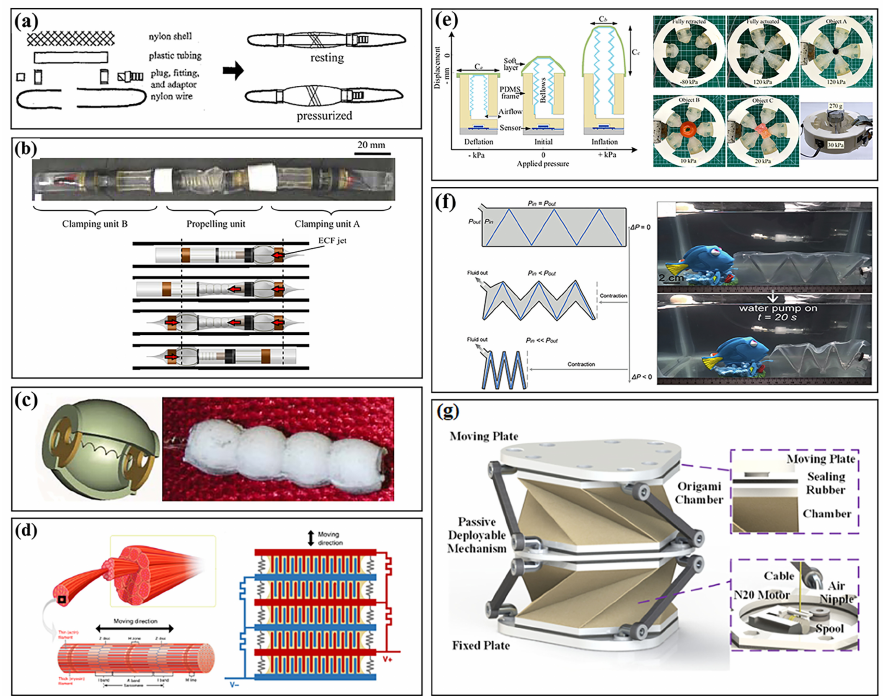
Figure 10. ( a ) The composition structure of McKibben artificial muscle and the forms in two states [88]. ( b ) The in-pipe mobile robot and locomotion of the in-pipe mobile robot [89]. ( c ) The structure of the module and the artificial earthworm prototype [90]. ( d ) Structure of skeletal muscles and stack schematic diagram of polymer interdigitated pillar electrostatic (PIPE) actuators, which are similar to the structure of natural muscles [91]. ( e ) Conceptual model of the bellows-driven soft actuator that represents smooth muscle contractions of a stomach [92]. ( f ) Schematic diagram of the operation of an actuator pulling an underwater fish for 3.5 cm in 20 s [93]. ( g ) Schematic diagram of a pneumatic/cable-driven hybrid linear actuator